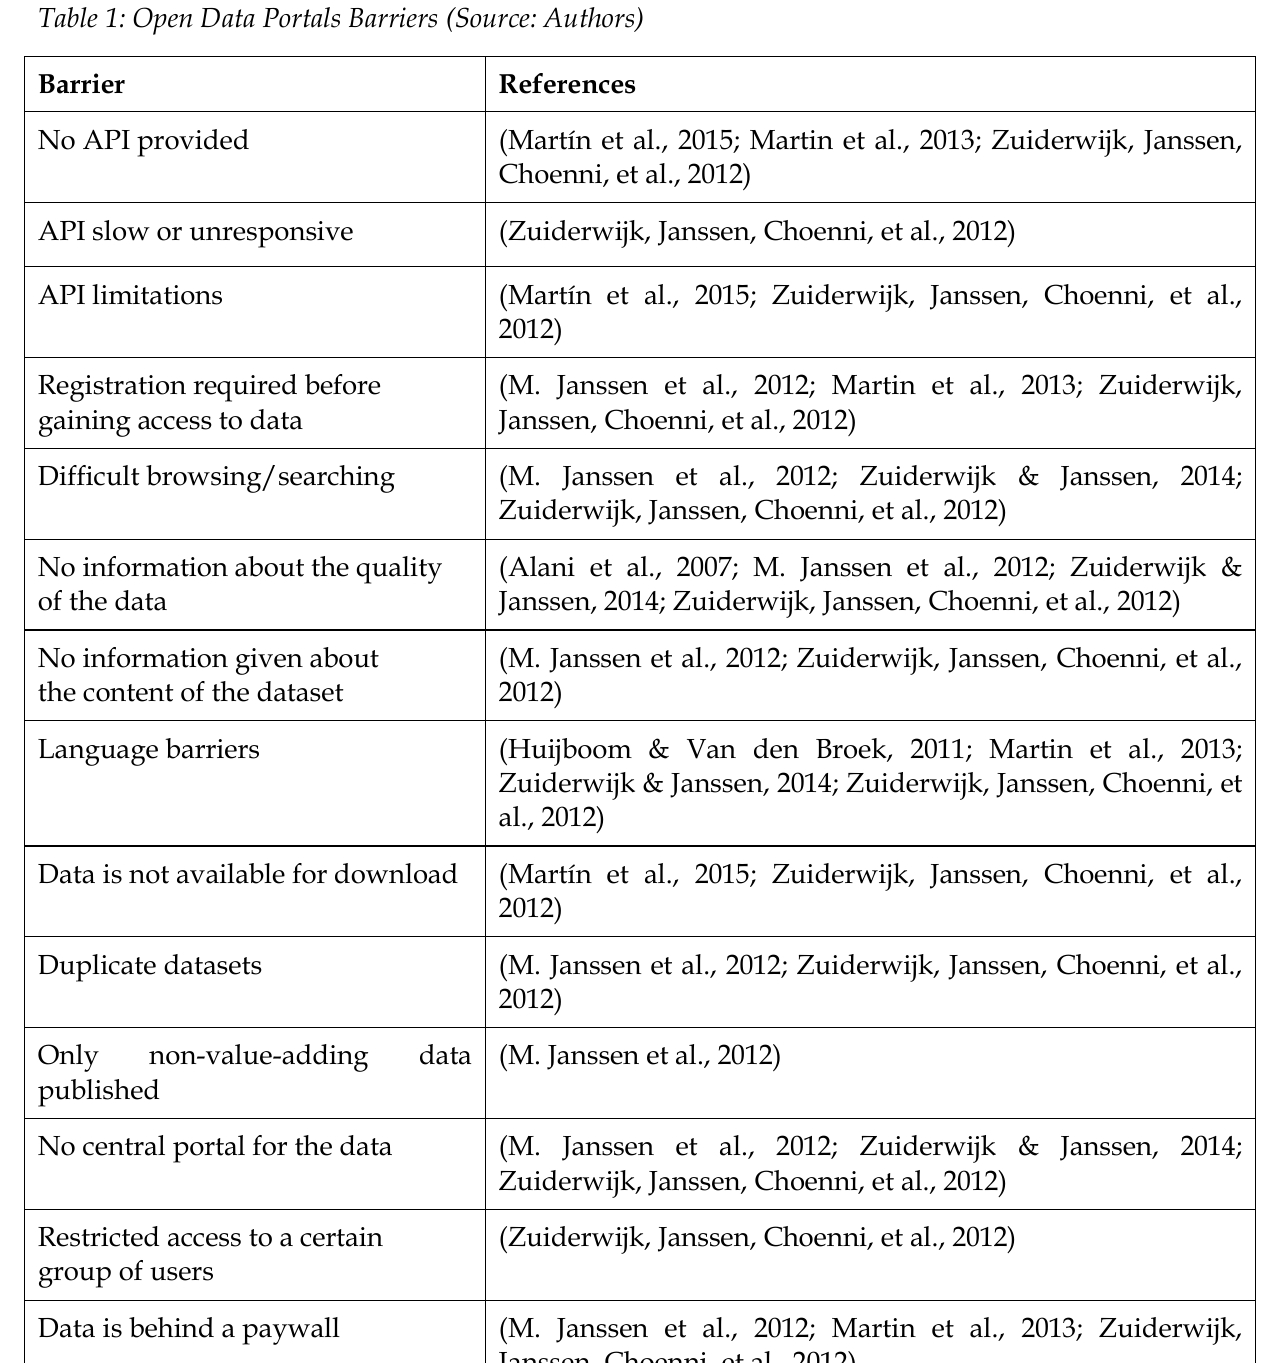
Table 1: Open Data Portals Barriers (Source: Authors)